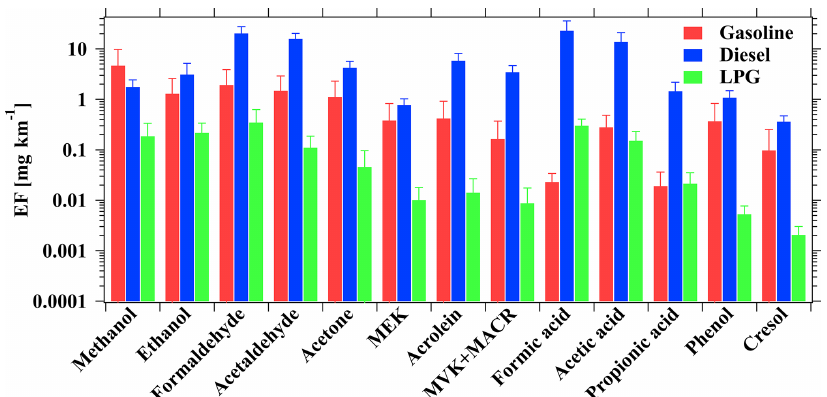
Figure 4. The determined emission factors of representative OVOC species from different types of vehicles. Error bars represent standard deviations of the emission factors for the